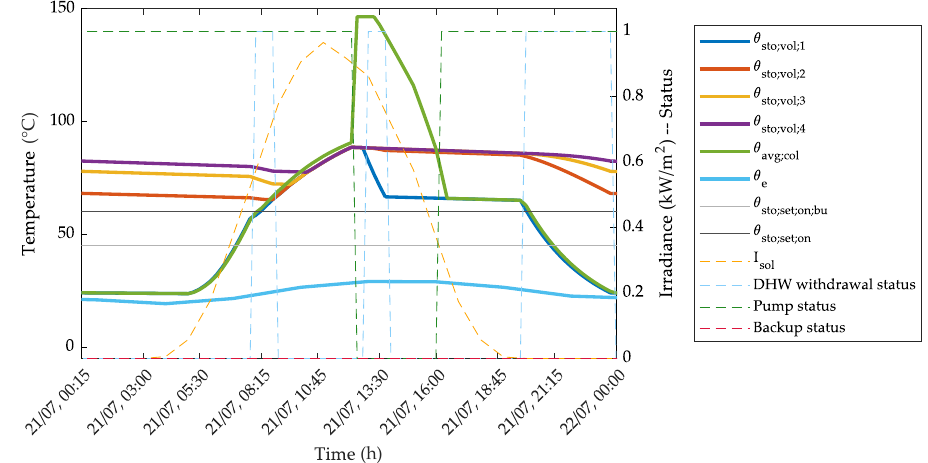
Figure 12. The effect of lower load pressure on system temperatures with an oversized solar field in summer, resulting in fluid boiling. Time step: 15 min.